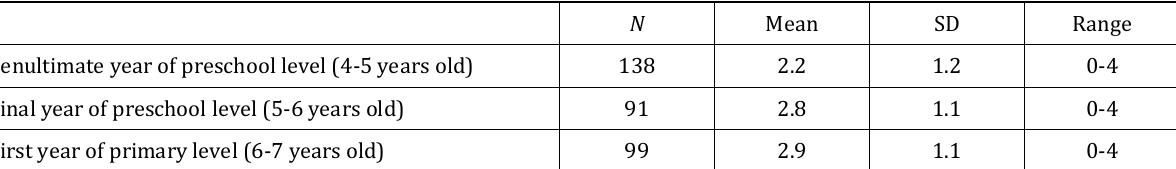
Table 6. Breakdown by educational level of the statistical descriptors of the number of responses awarding more severity to transgressions related to moral domain rather than to those linked to the socio-conventional domain N Mean